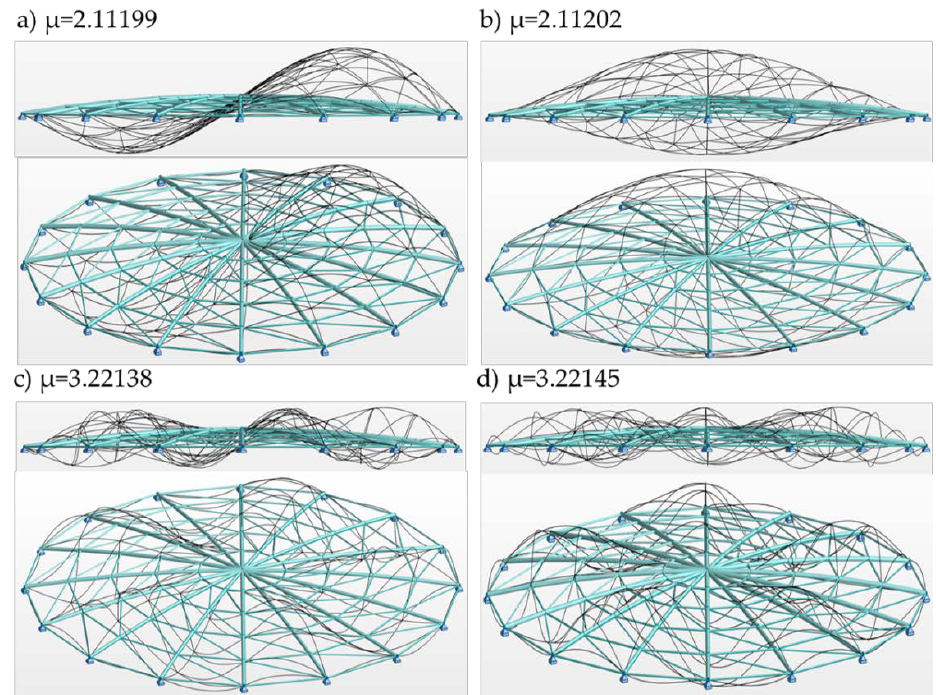
Figure 17. Buckling modes of the structure: ( a ) 1st, ( b ) 2nd, ( c ) 3rd, ( d ) 4th.